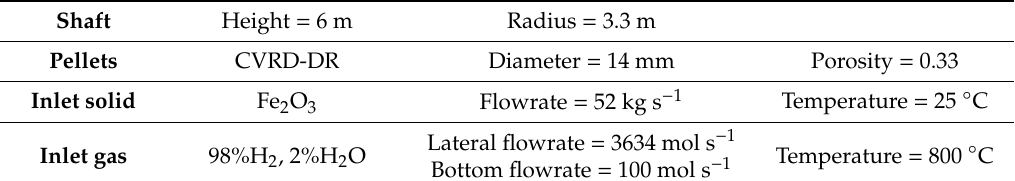
Table 2. Main operating conditions for the reference simulation.